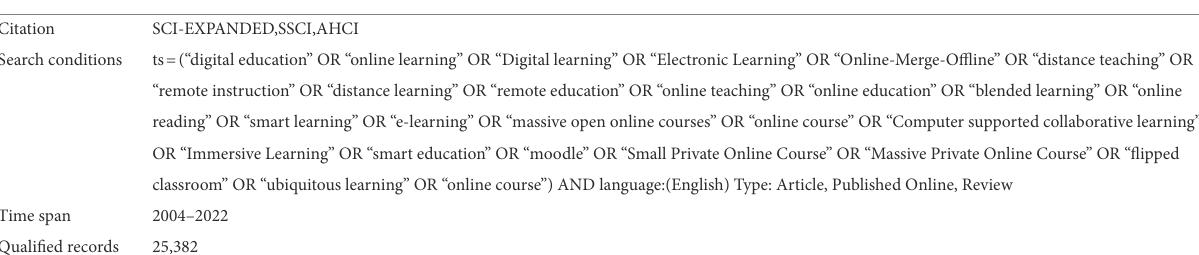
TABLE 1 Detailed search setting